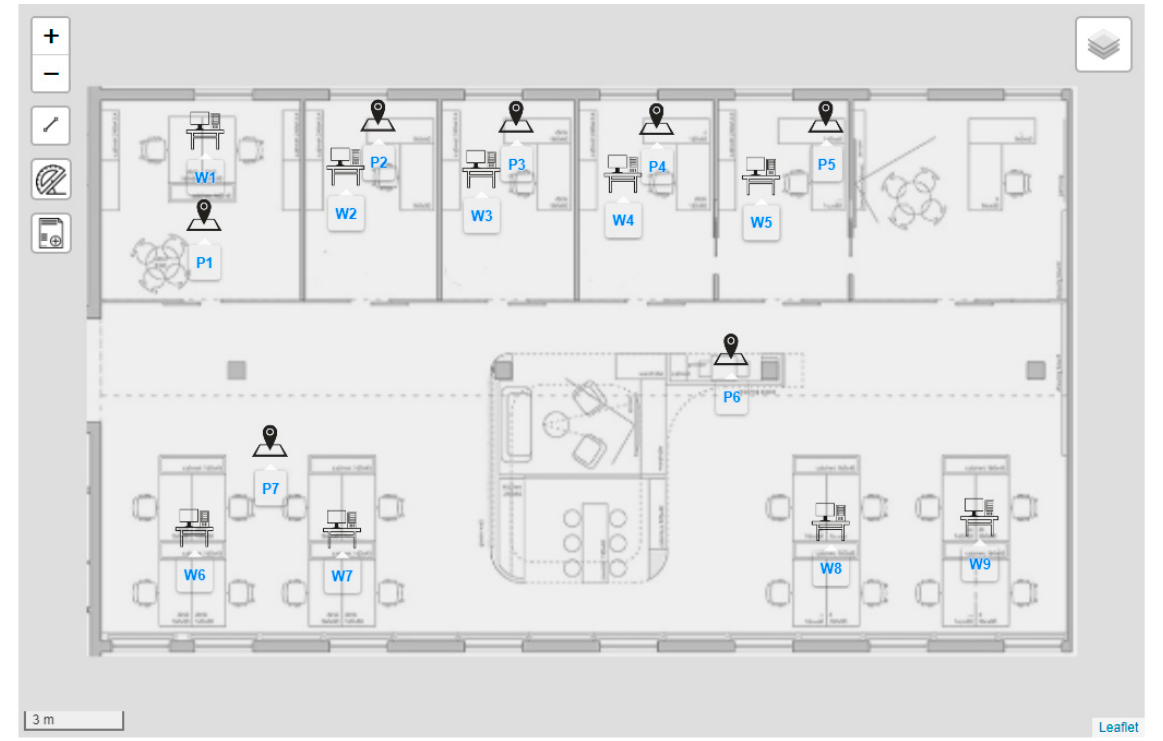
candidate location P6 and other devices within their physical vicinity (green colored links Figure 5. Case study floor plan ‐ candidate locations, workstations, and printing devices. Figure 5. Case study floor plan-candidate locations, workstations, and printing devices. in Figure 6). The links in red color indicate the restricted access to specific devices.